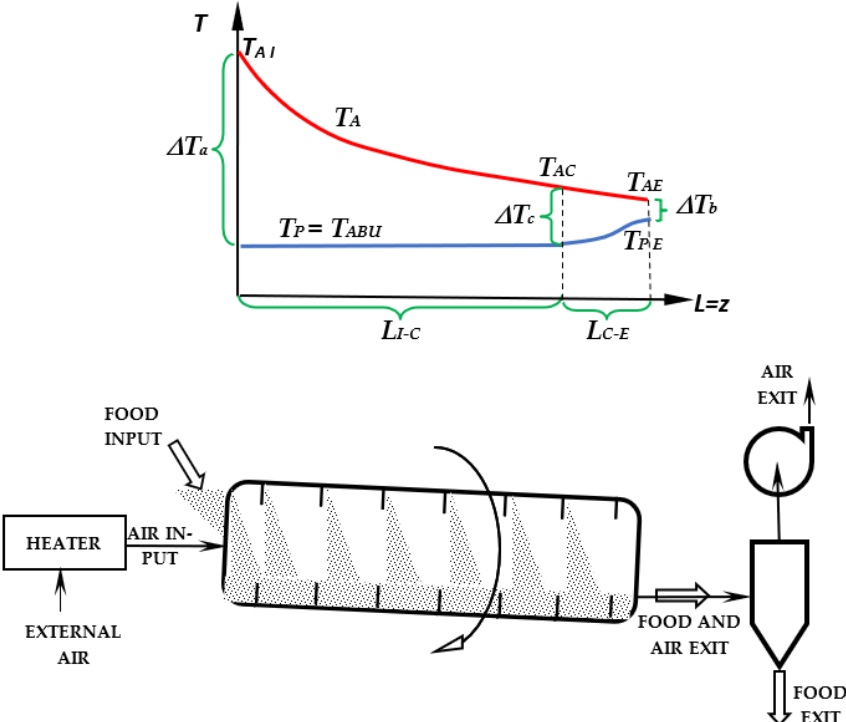
Figure 1. Rotary drum dryer mass flows and diagram of the temperature of the air (red line) and the product (blue line). The product has final moisture content X E < X C .